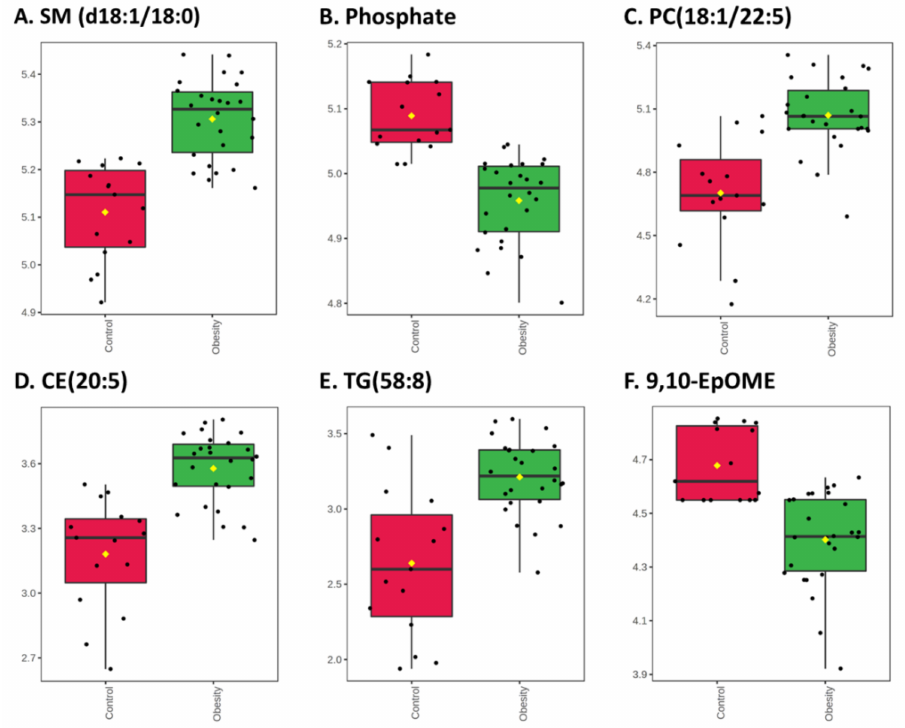
Figure 3. Box-plots of selected metabolites with significantly different concentrations between chil- dren with (green) and without (red) obesity. Fold changes and p -values are provided in Table S1. ( A ) Sphingomyelin (SM) d36:1 (d18:1/18:0); ( B ) Phosphate; ( C ) Phosphatidylcholine (PC) 40:6 (18:1/22:5); ( D ) Cholesteryl eicosapentaenoic acid (CE (20:5); ( E ) Triacylglycerol (TG) 58:8; ( F ) 9,10- epoxyoctadecenoic acid